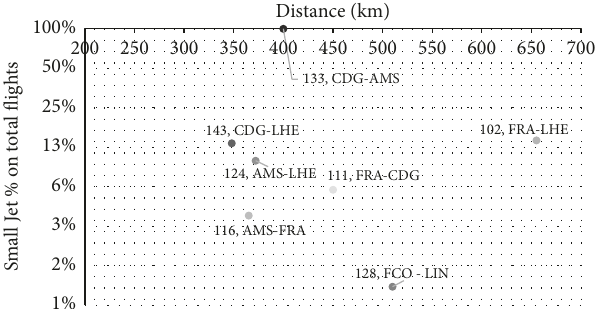
Figure 2: CO 2 emissions as function of the distance and the Small Jet to Narrow Body share (gCO 2 /PKM).